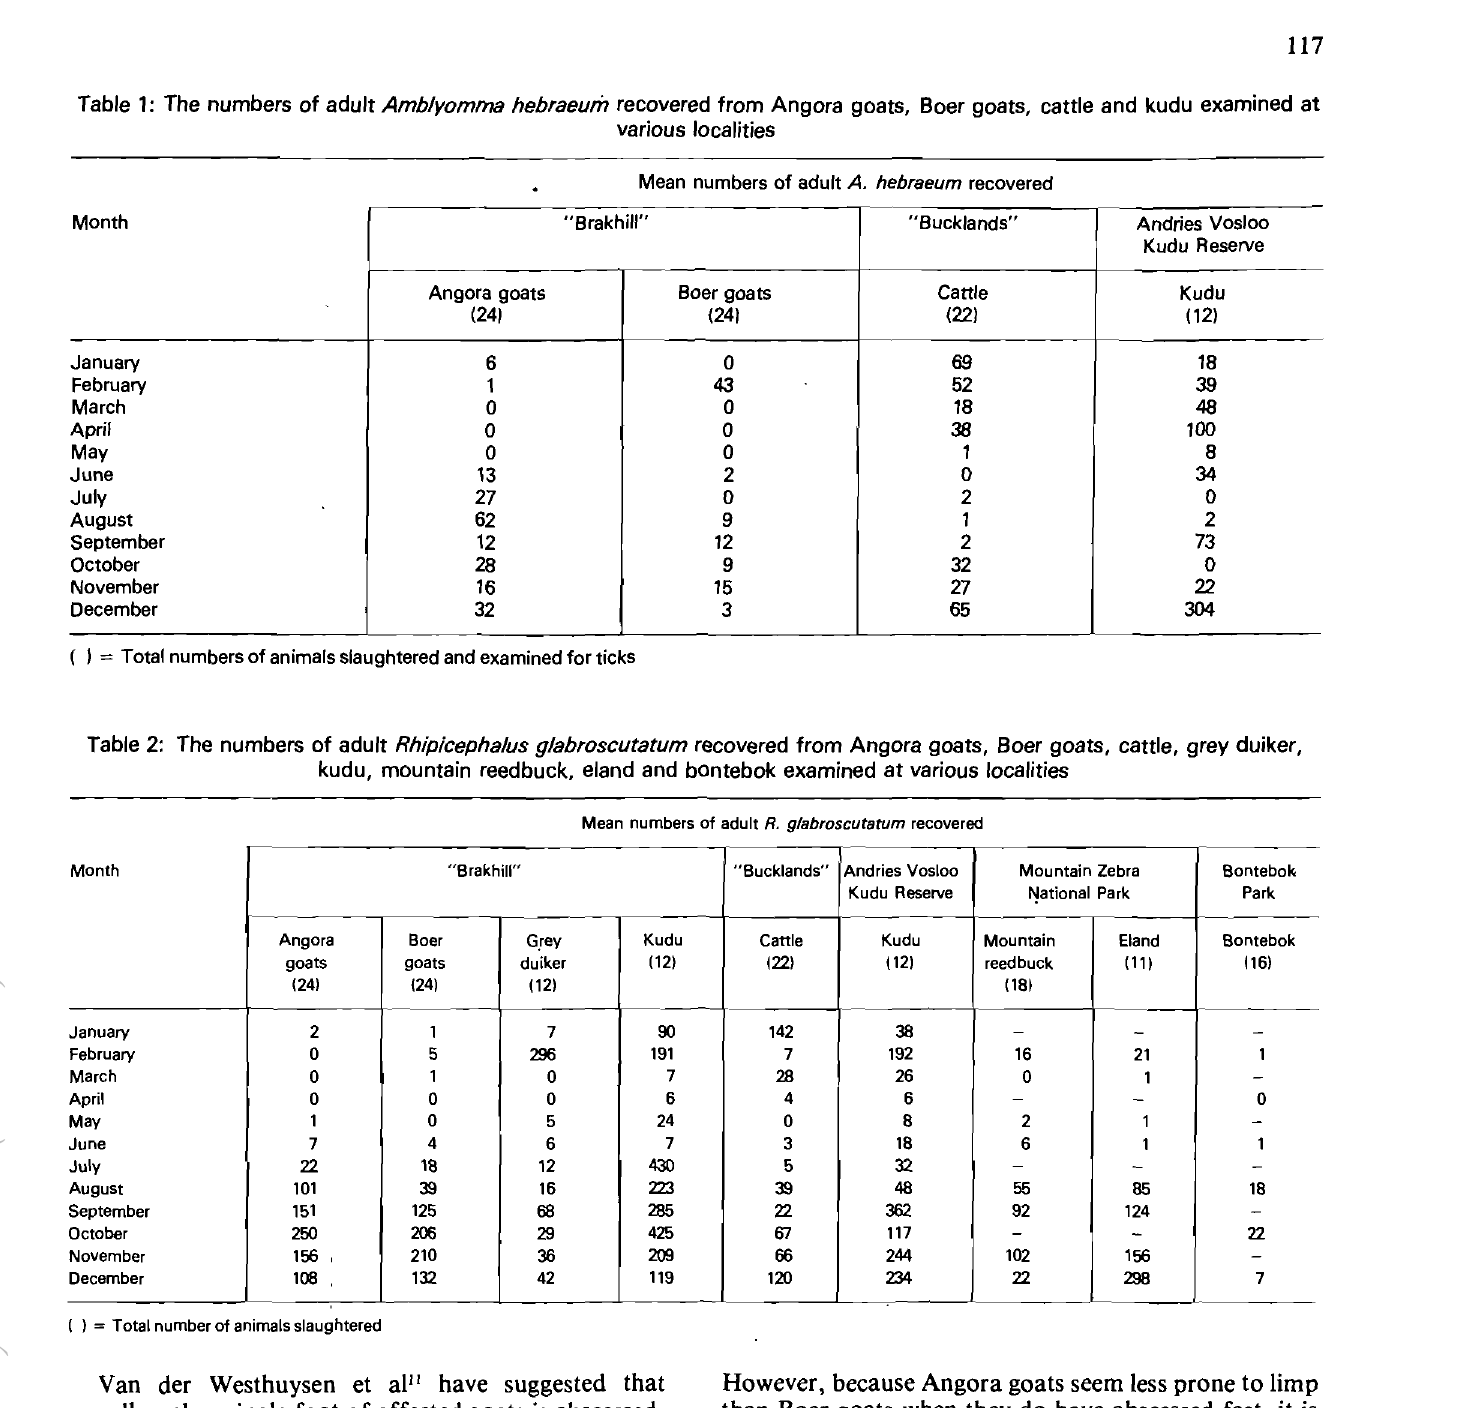
Table 2: The numbers of adult Rhipicephalus glabroscutatum recovered from Angora goats, Boer goats, cattle, grey duiker, kudu, mountain reedbuck, eland and bontebok examined at various localities Mean numbers of adult R. glabroscutatum